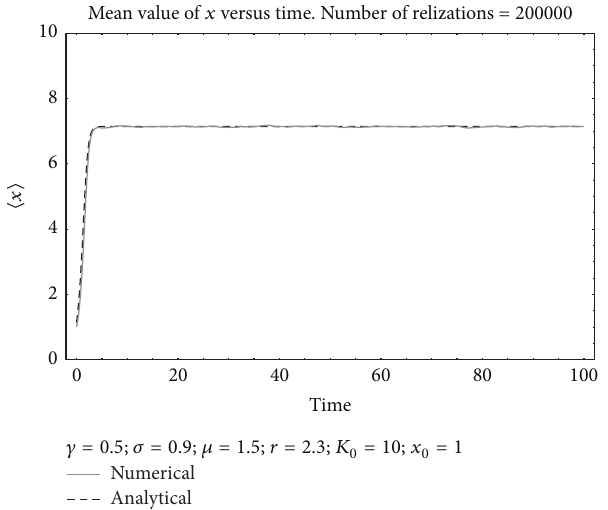
Figure 2: The plot of the mean value of 𝑥(𝑡) versus time in arbitrary units. The values of the parameters are 𝑥 0 = 1 , 𝛾 = 0.5 , 𝜎 = 0.9 , = 10 , and 𝑟 = 2.3 . The analytical value of ⟨𝑥(𝑡)⟩ is given 𝜇 = 1.5 , 𝐾 0 by (18). The agreement between the analytical expression (dashed line) and the numerical simulation (continuous line) is remarkable.